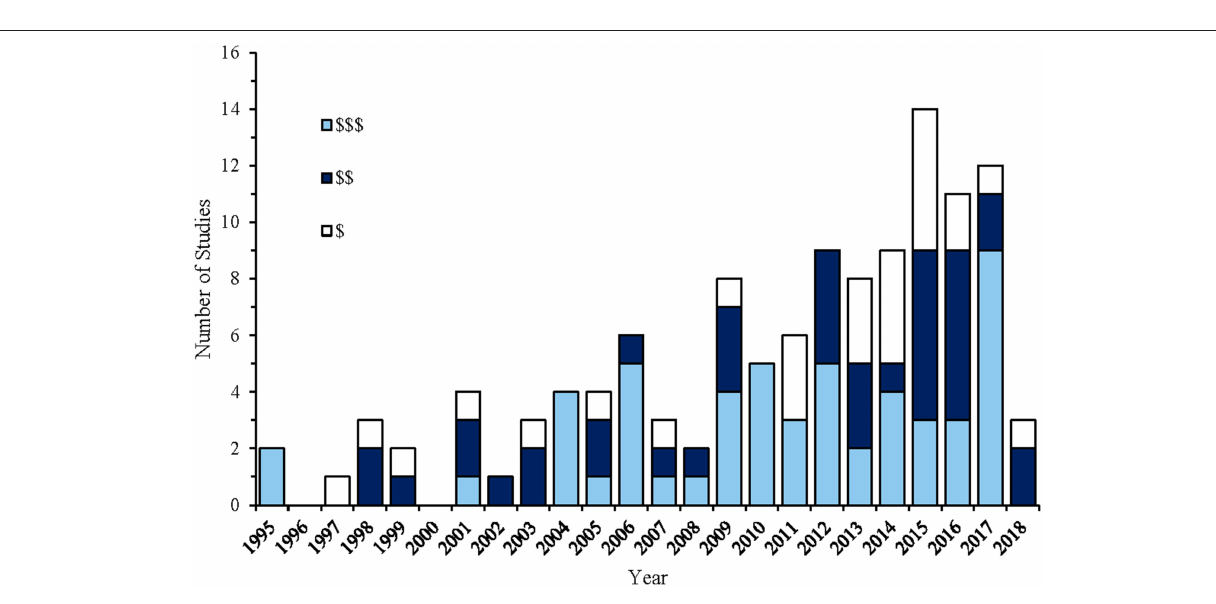
FIGURE 3 | Temporal trends in the approximate cost of ROV’s that have been used in studies to visually assess fish assemblages, with $, Tens of thousands; $$, hundreds of thousands; and $$$, millions of Australian